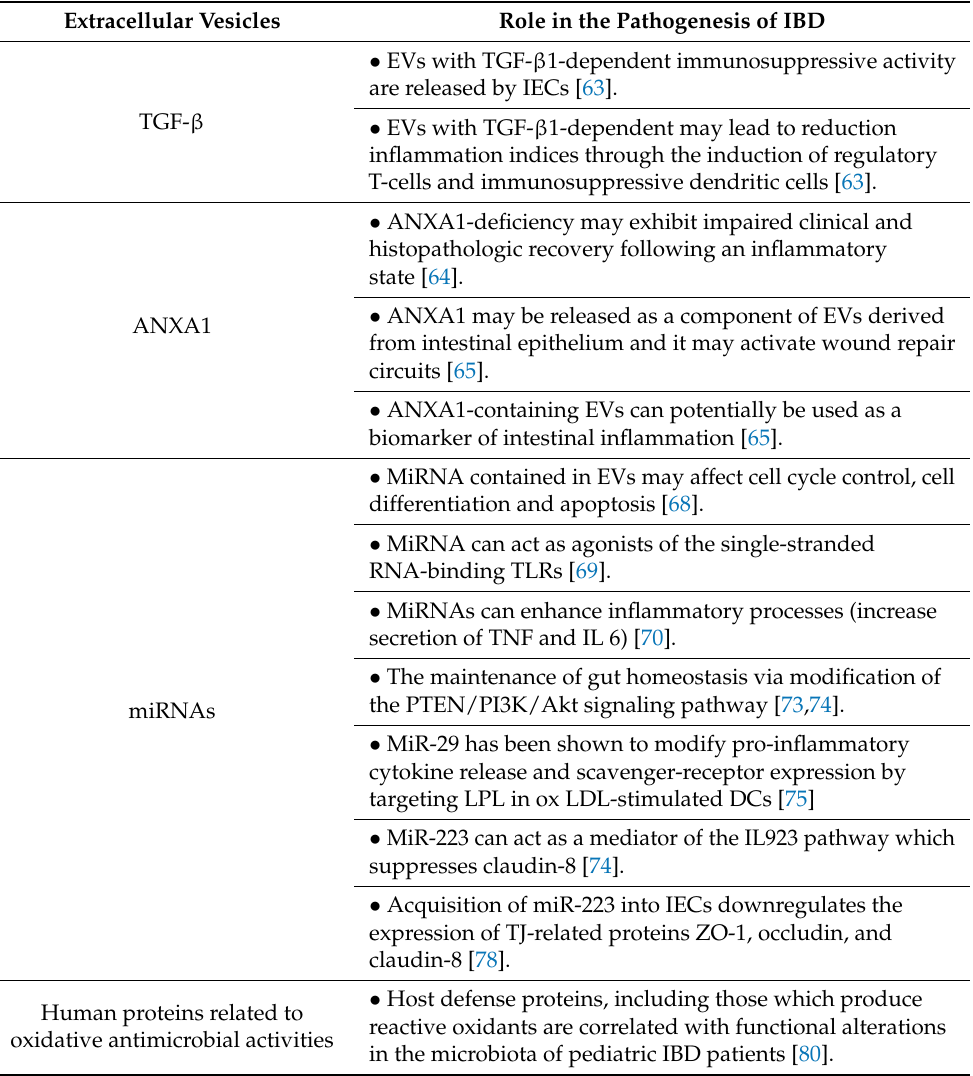
Table 1. Extracellular (EVs) vesicles in the pathogenesis of